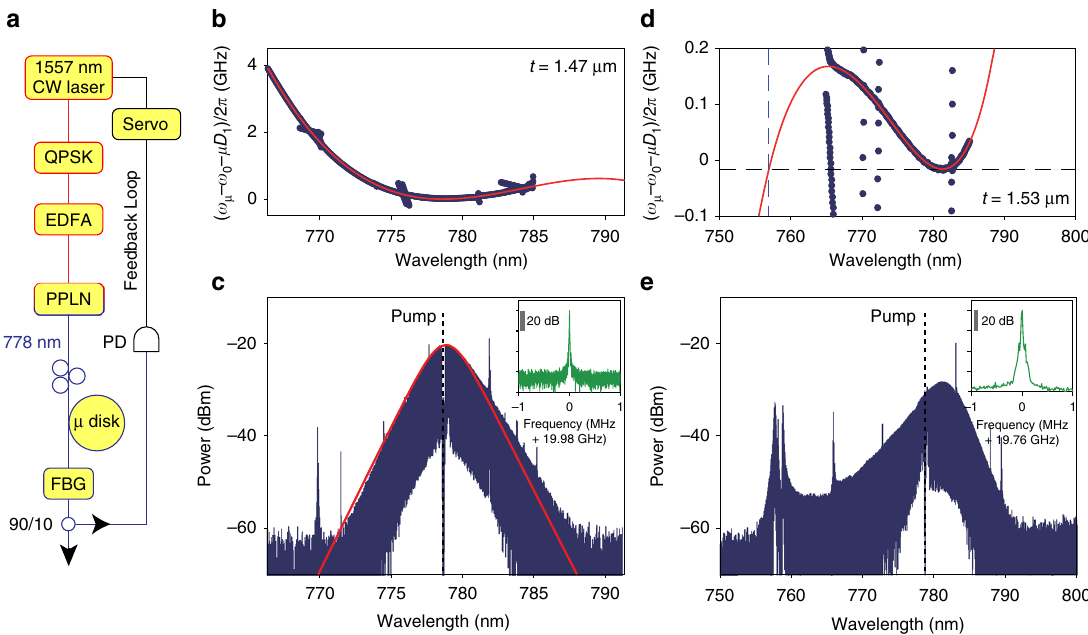
Fig. 4 Solition generation at 778 nm. a Experimental setup for soliton generation. A 1557nm tunable laser is sent to a QPSK modulator to utilize frequency- kicking 57 and is then ampli fi ed by an EDFA. Then, a PPLN waveguide frequency doubles the 1557nm input into 778 nm output. The 778 nm pump light is coupled to the resonator for soliton generation. A servo loop is used to maintain pump locking 53 . b Measured relative mode frequencies of the TM1 mode family vs. wavelength for devices with t = 1.47 µ m. A number of crossing mode families are visible. The red curve is a numerical fi t using D 2 /2 π = 49.8 kHz and D 3 /2 π = 340 Hz. c Optical spectrum of a 778 nm soliton generated using the device measured in b with pump line indicated by the dashed vertical line. The red curve is a spectral fi tting which reveals a pulse width of 145 fs. Most of the spurs in the spectrum correspond to the mode crossings visible in b . Inset shows the electrical spectrum of the detected soliton pulse stream. The resolution bandwidth is 1 kHz. d Measured relative mode frequencies of the TE2 mode family vs. wavelength for devices with t = 1.53 µ m. The red curve is a fi t with D 2 /2 π = 4.70 kHz and D 3 /2 π = − 51.6 Hz. e Optical spectrum of a soliton generated using the device measured in d with pump line indicated as the dashed vertical line. A dispersive wave is visible near 758 nm. Inset shows the electrical spectrum of the detected soliton pulse stream. The resolution bandwidth is 1